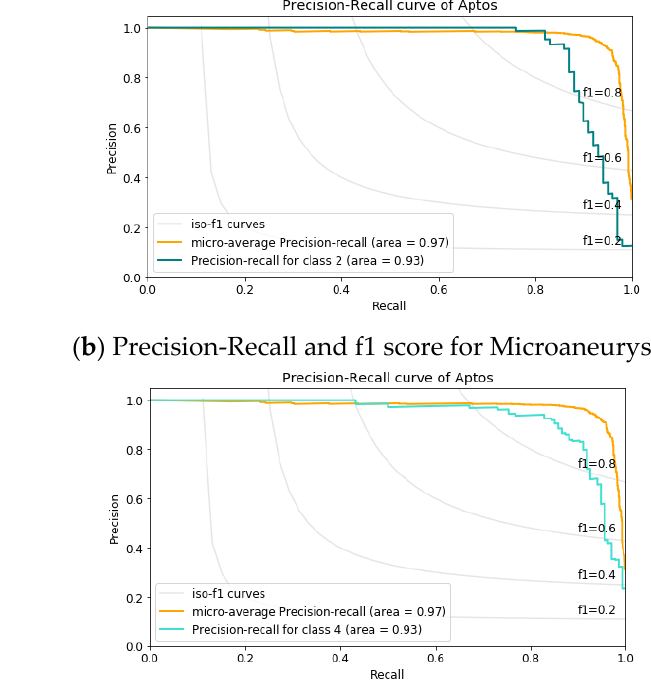
Figure 7. Precision-Recall and f1 score analysis for APTOS dataset.